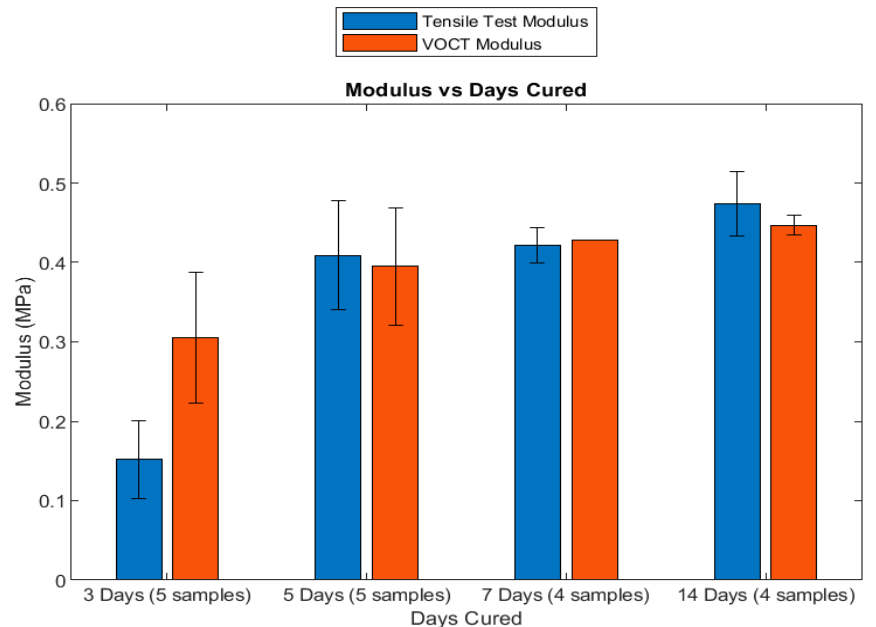
Figure 6. Moduli and their standard deviation according to days cured based on VOCT measurements for silicone specimens at 0% strain (control condition) and tensile testing. Note that the VOCT-calculated modulus for specimens cured for 7 days has a standard deviation of 0.